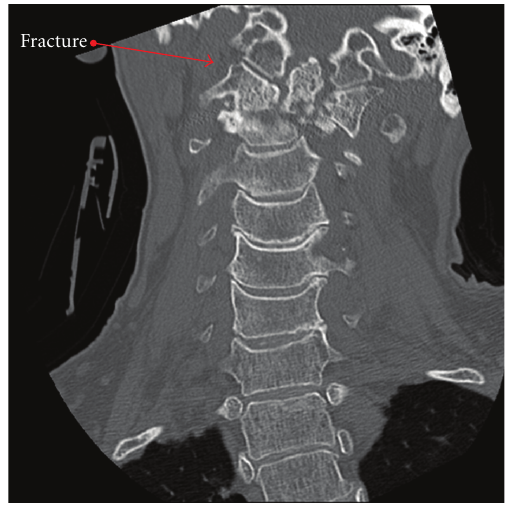
Figure 3: Frontal